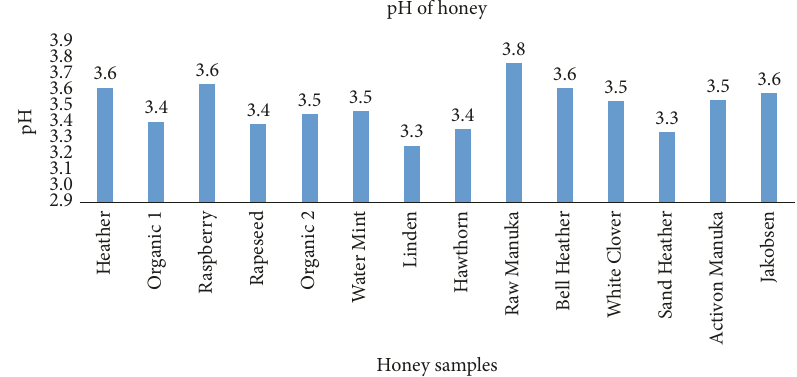
Figure 5: pH values of the 14 tested honey samples. The measurements are performed on a solution of 20% honey ( 𝑛 = 1 ).